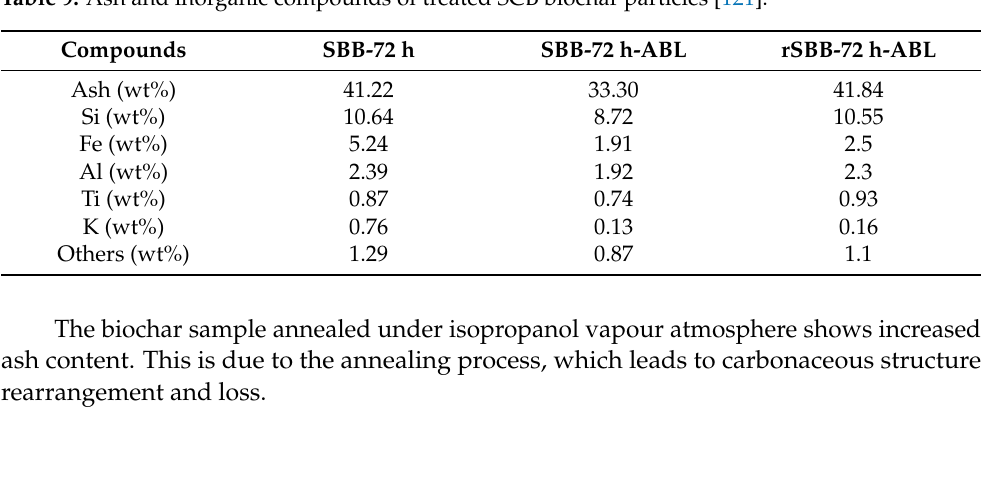
acid–base-leached biochar particles show a 20% reduction in ash, 63% reduction in iron,